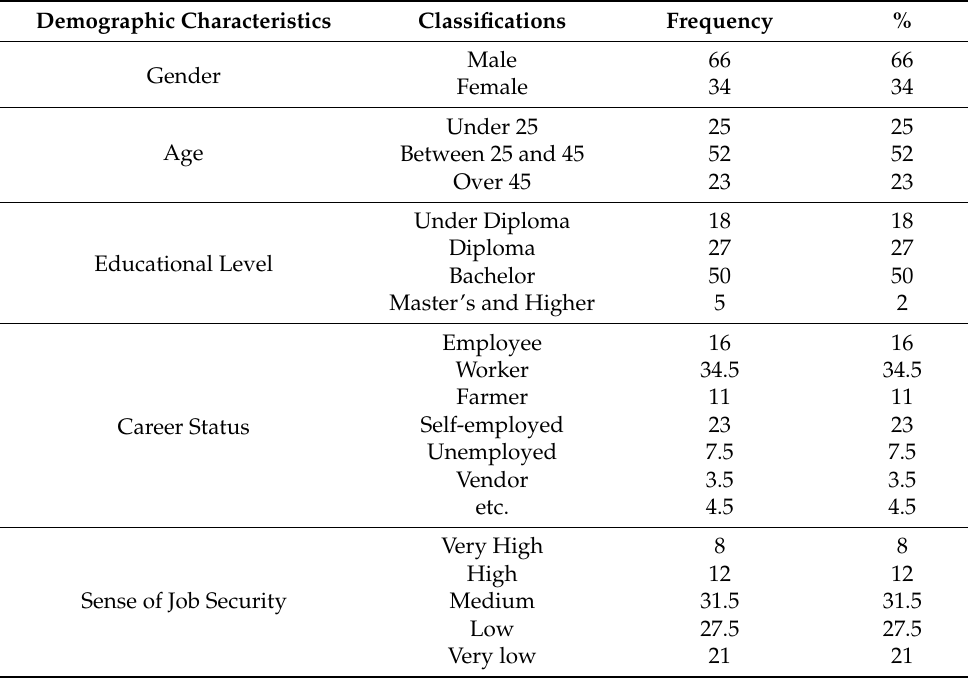
Table 2. The demographic status of the